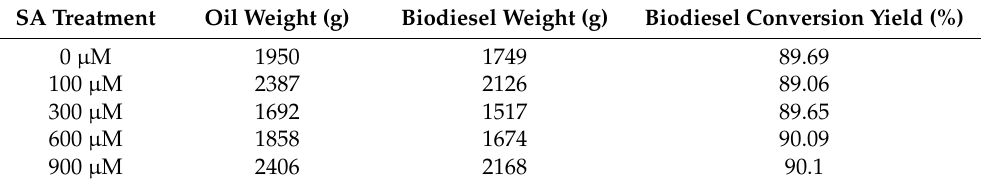
Table 4. Oil transesterification